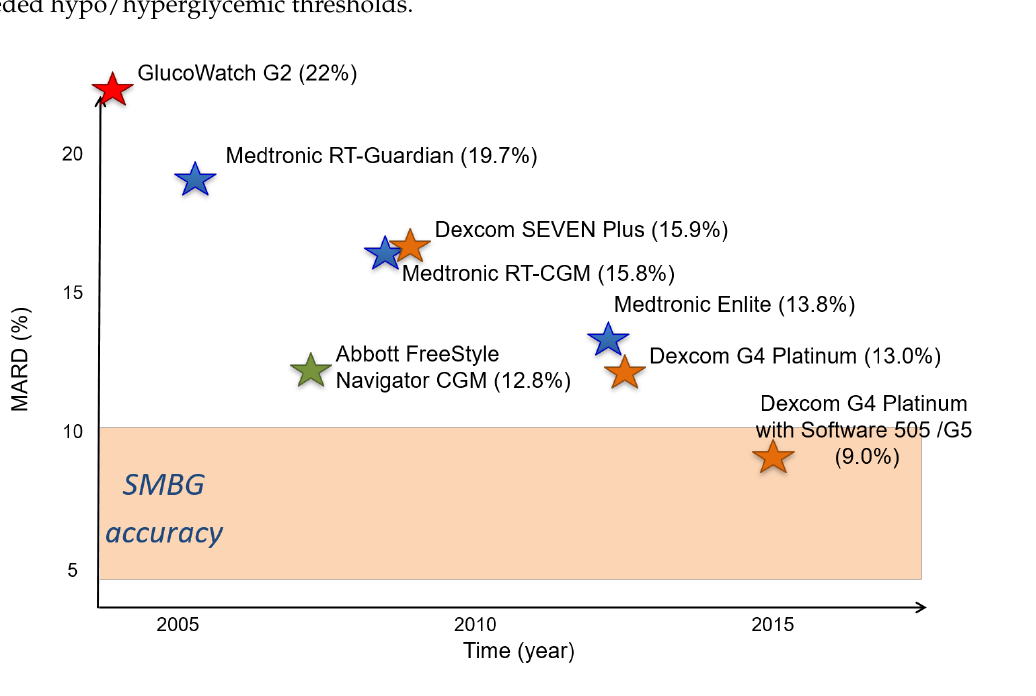
Figure 1. The accuracy timeline of CGM sensors over the last 15 years.